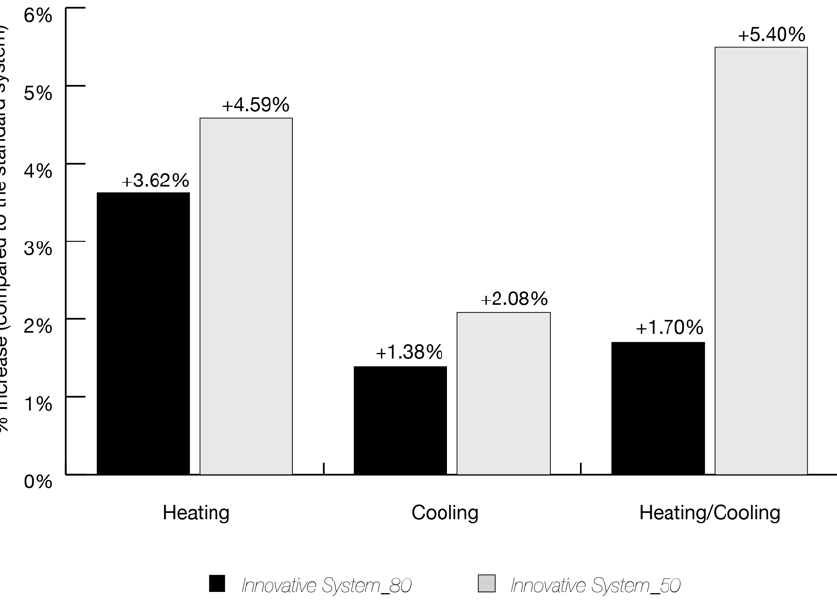
Figure 10. Thermal exchange increase between CF-I80 and CF-I50 composite probe for heating, cooling and heating/cooling thermal tests.